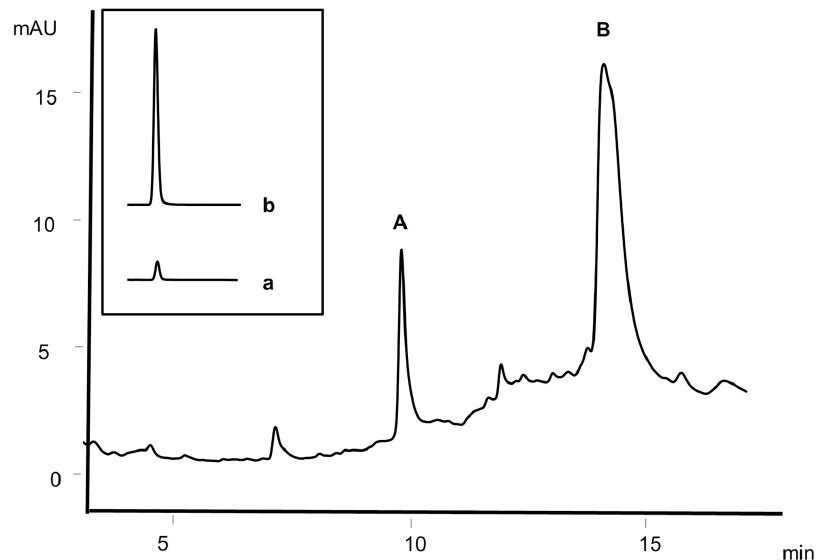
Fig 2. HPLC chromatogram of plasma after treating with de-conjugating enzymes. A, caffeic acid and B, elagicacid (Internal standard). Inset: Signalareas of caffeic acid transportedthrough Caco-2 cell monolayers; a, caffeic acid signal in the control with no added lauric acid, b, caffeic acid signal in the sample with added lauric acid at 2.5 mmol/L.